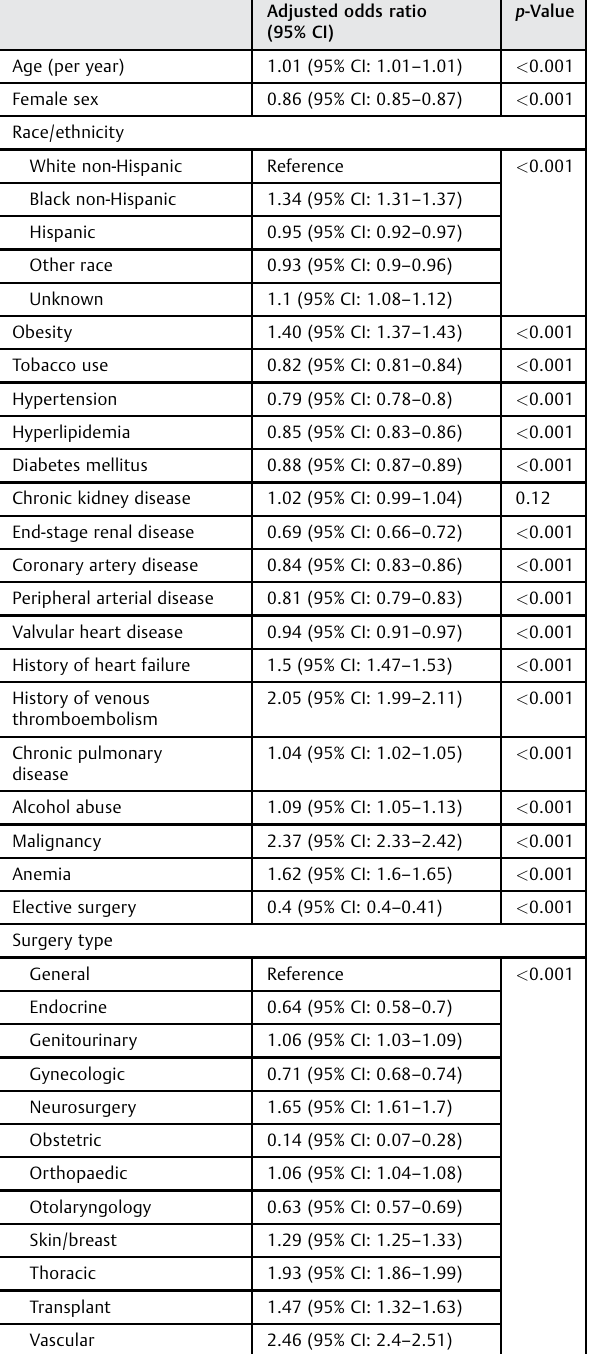
Table 2 Predictors of venous thromboembolism during hospitalization for major noncardiac